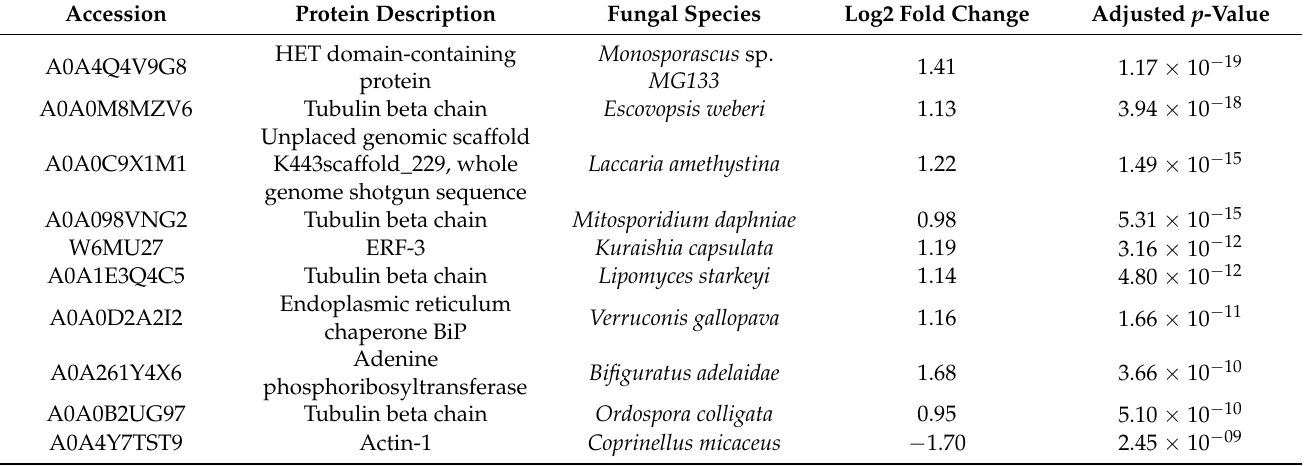
Figure 3. Volcano plot of differentially abundant fungal proteins: Differentially (purple) and non- differentially (green) abundant fungal proteins between OSCC and NAT patient samples (adjusted p -value < 0.05) determined by statistical t -testing using Benjamini–Hochberg correction. The log 2 fold change reflects the ratio of normalised TMT-label intensities between tumour OSCC and healthy NAT conditions. The horizontal dotted line represents an adjusted p -value of 0.05. Vertical dotted lines represent ± 1 log 2 fold change. UniProt accession numbers are shown for the top 30 most significant proteins. Table 1. Significantly differentially abundant fungal protein details: Information on the top 30 significant proteins from Figure 3. Information for all significant proteins can be viewed in Supplementary File S3. UniProt accession numbers, protein description, corresponding species, log 2 fold change, and adjusted p -values are shown. Entries are sorted by ascending adjusted p